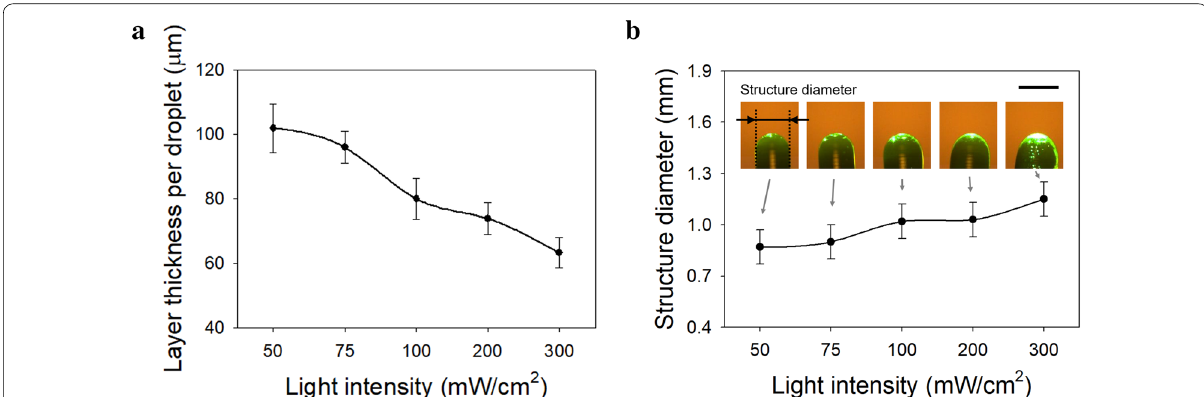
Fig. 2 Structural dimensions depending on light intensities (mW/cm 2 ). a Layer thickness per droplet (μm). b Structure diameter (mm). The scale bar is 1